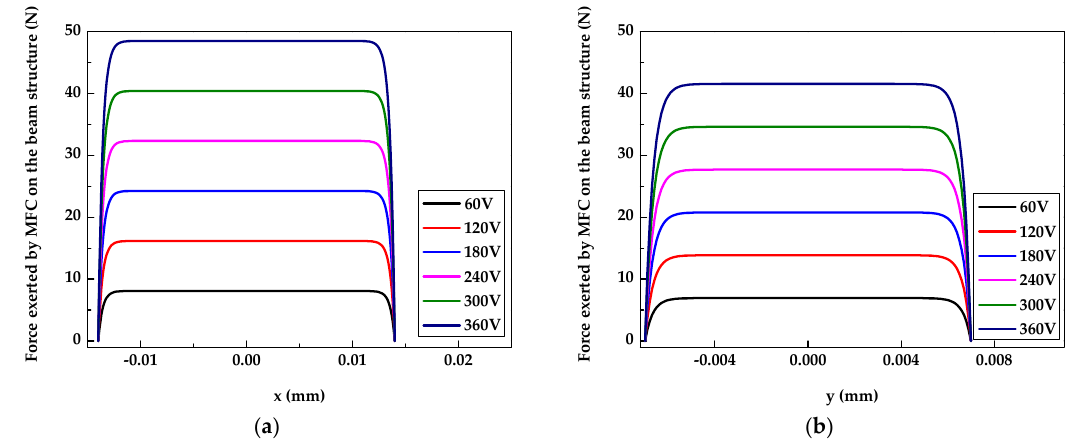
Figure 8. The mean internal force distribution of the M2814-P2 type of MFC under different voltages. ( a ) The direction of the x axis; ( b ) The direction of the y axis.